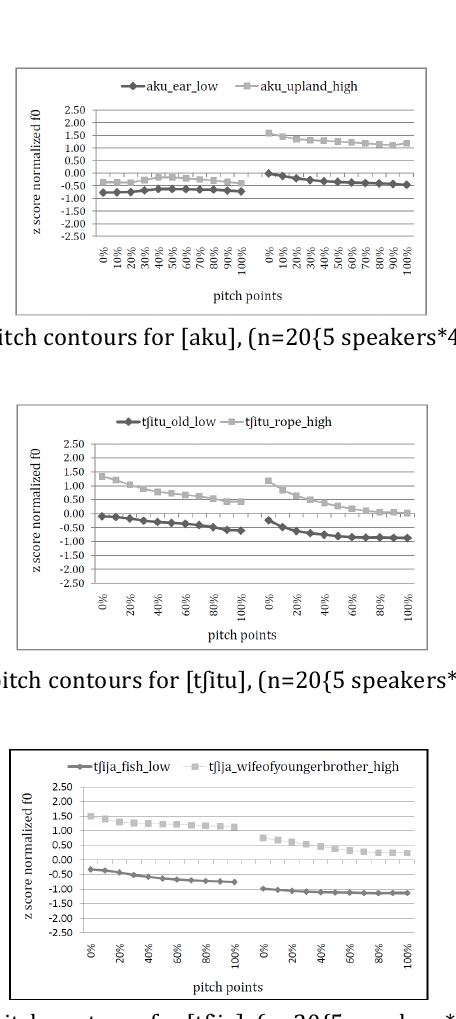
Figure 11: Normalized pitch contours for [tʃija], (n=20{5 speakers*4 iterations each})